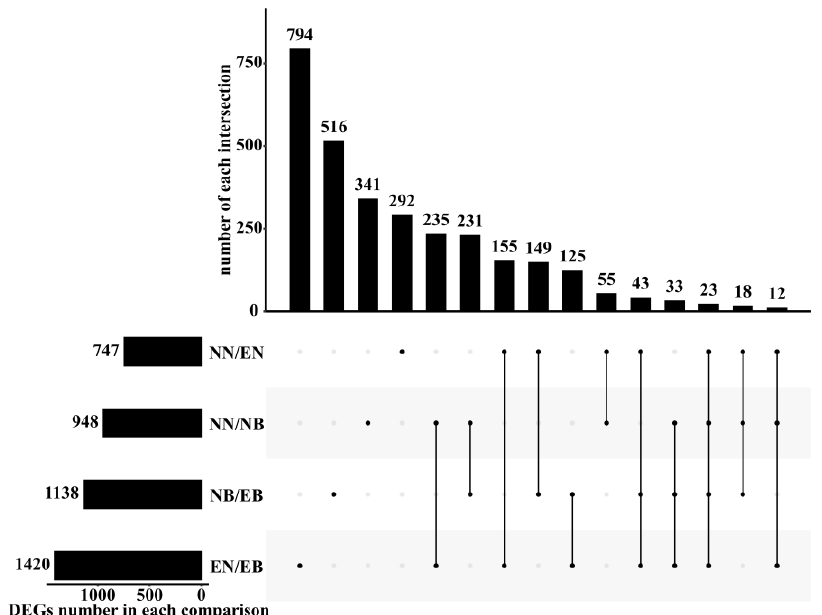
Figure 1. Upset diagram of differentially expressed genes. DEGs number in each comparison group represents the number of all DEGs in each comparison group; the number of each intersection represents the total number of DEGs in each comparison group; a point on the abscissa represents the number of unique DEGs in each comparison group; the line of multiple dots on the abscissa indicates the number of DEGs identified by the multiple comparison groups of the